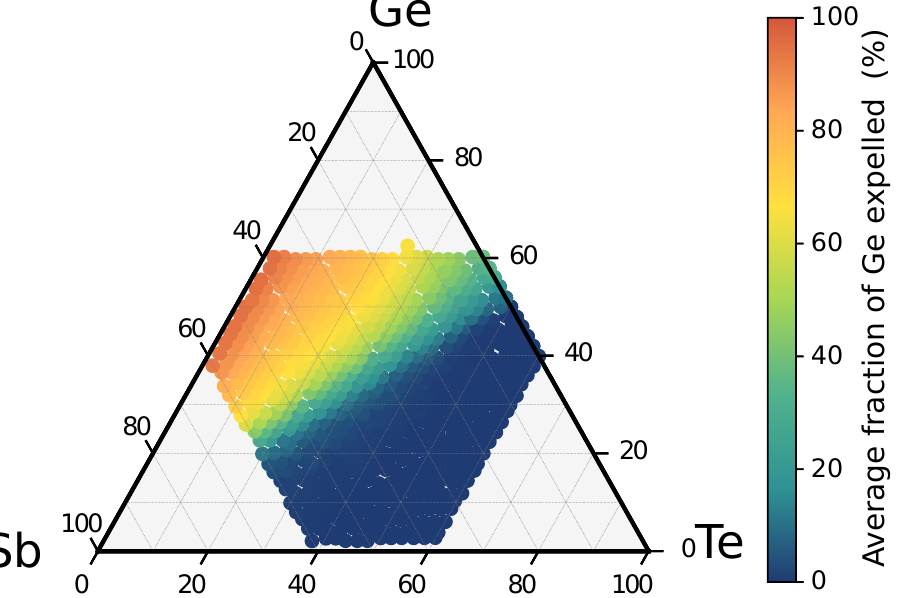
Figure 6. Map of the average fraction of crystalline Ge in atomic % segregated in the exothermic decomposition reactions of GST alloys in the central part of the ternary phase diagram (see text for